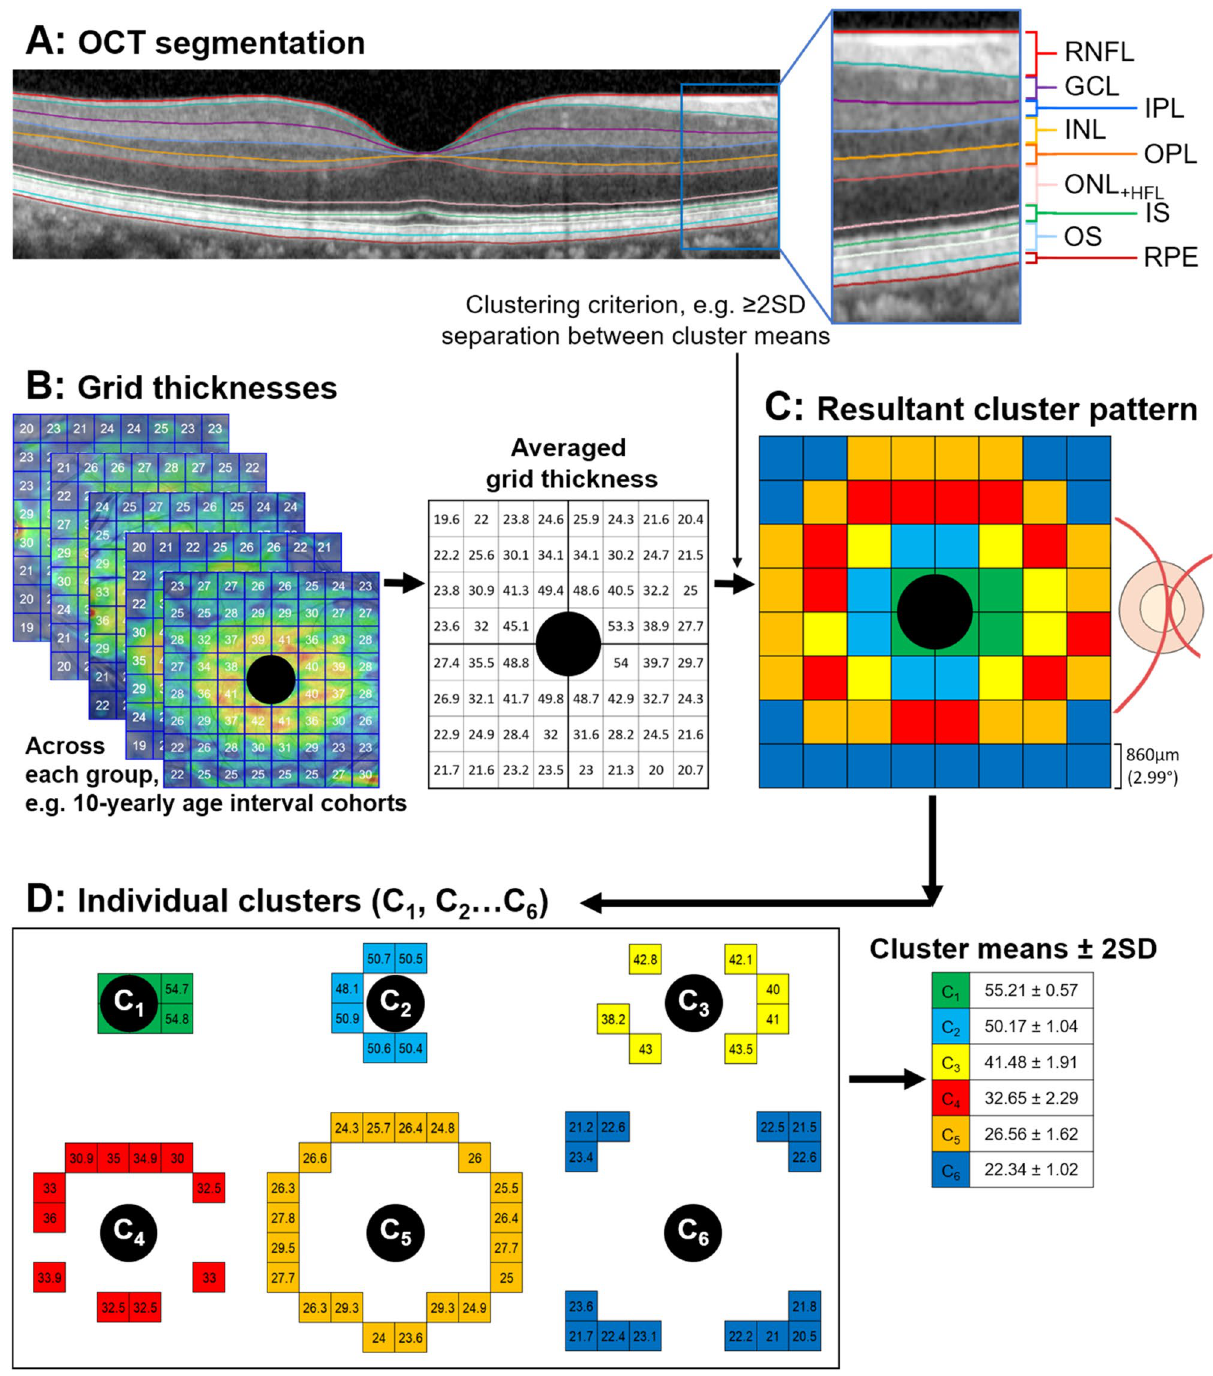
Figure 1. ( A ) Retinal layers segmented within the HRA/Spectralis Viewing module – manual correction was performed when necessary. ( B ) Individual retinal layer thicknesses across each group (i.e. variables that were significantly associated with average retinal layer thickness, such as age or sex). The Spectralis 8 × 8 grids are centred on the fovea with each grid location covering 0.74 mm 2 (approximately 3° × 3°). Values presented are a sample of GCL thicknesses in µm. For each group, averaged thickness were then determined at each grid location ( middle ). ( C ) Values were then clustered by statistically similar thicknesses based on applied criterion of at least 2SD separation (d ′ ≥ 2) between cluster means. The resultant spatial cluster topography is generated by the various pseudo-colours. Note all images are in right eye format, demonstrated by the location of the optic nerve. Scale bar is provided in the bottom left. ( D ) A visual and numerical break-down of the individual clusters, demonstrating a concentric pattern. GCL, ganglion cell layer; IPL, inner plexiform layer; INL, inner nuclear layer; OPL, outer plexiform layer; ONL +HFL , outer nuclear layer + Henle’s fibre layer; IS, photoreceptor inner segment layer; OS, photoreceptor outer segment layer; RPE, retinal pigment epithelium. C 1…6 = Clusters